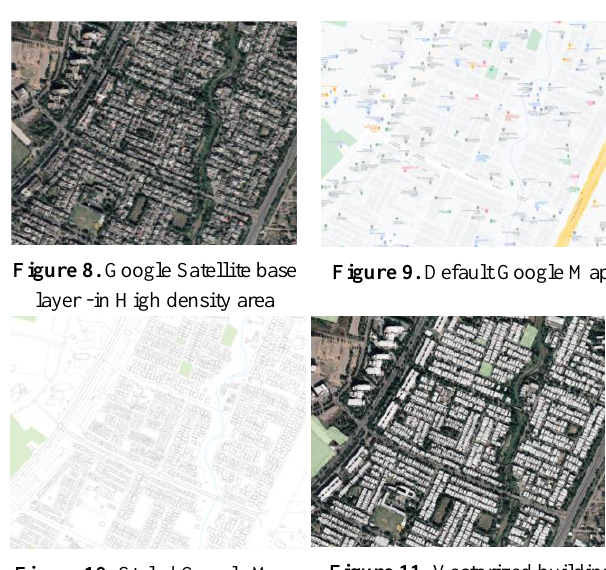
Figure 10. Styled Google Map Figure 11. Vectorized building labels and raster map